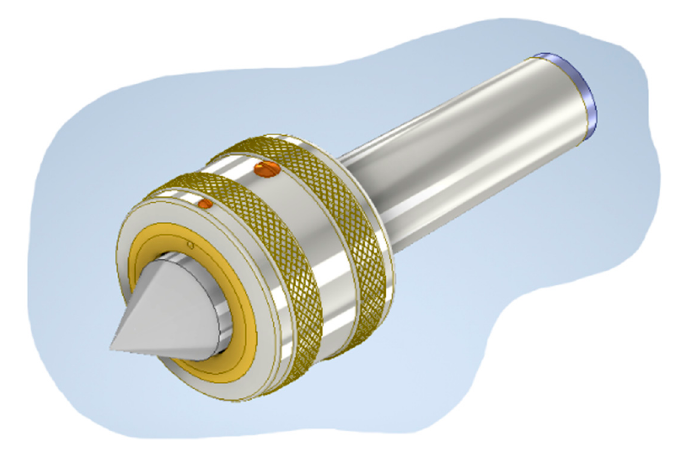
Figure 4. Rendered image of the tailstock.